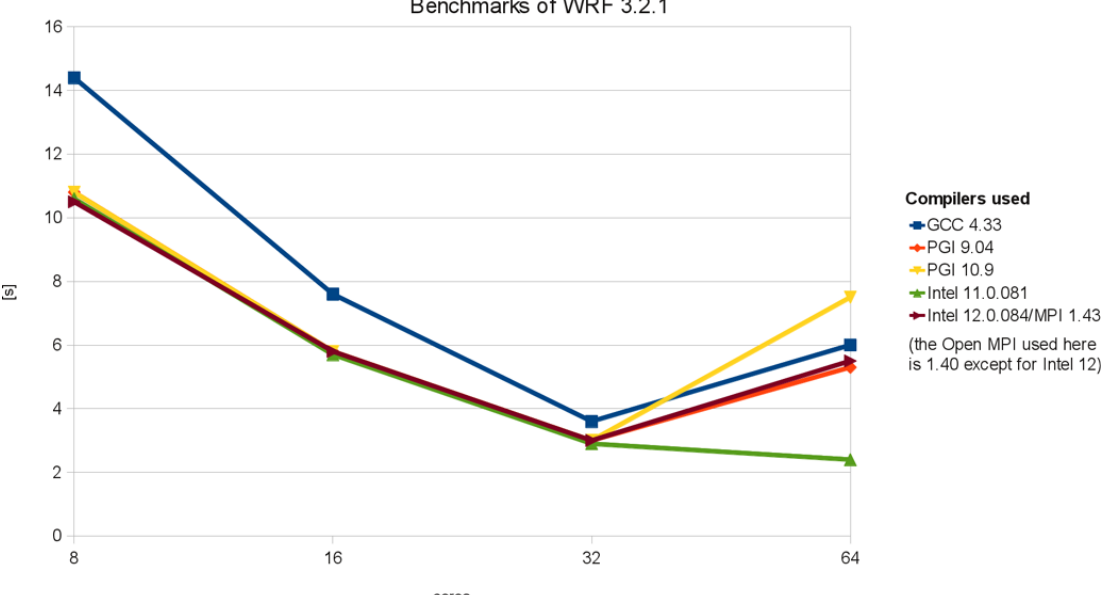
Fig. 4. Data of Table 1, but for Open MPI 1.40/1.43 only. All results are minimal seconds needed for one of 45 model time steps of the Default January 2000 case at 3.33km horizontal resolution. The runs with 64 cores are strongly varying and were sometimes not reproducible ( > 5